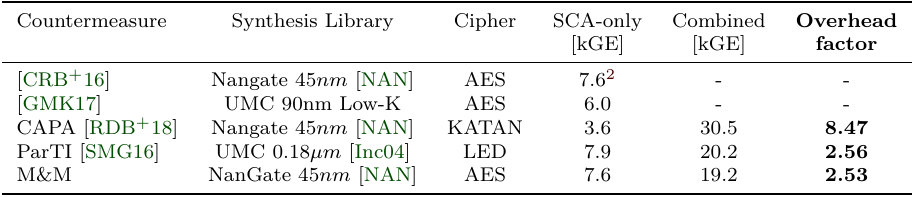
Table 3: Area comparison for first-order secure implementations Countermeasure